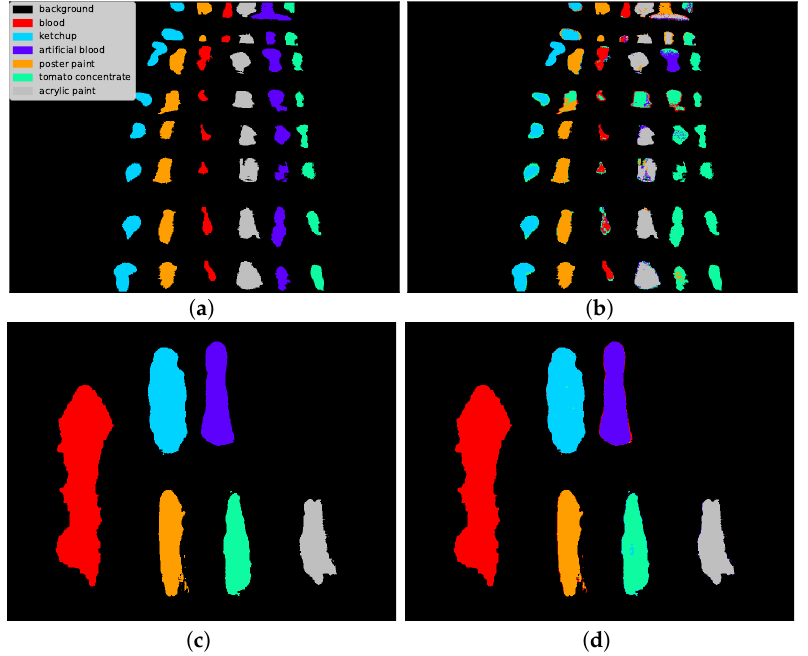
Figure 13. Two selected examples of classification maps for sample runs of the RNN [14] and 3D CNN [49] architectures in the HIC scenario. For the E(1) image, where the training spectra originated from a distinct data cube i.e., F(1) , some classes (e.g., artificial blood and tomato concentrate) were misclassified. However, for the F(2k) image where the training data cube i.e., F(2) originated from the same scene, classification errors are minor, despite the fact that both images were acquired with different hyperspectral cameras. ( a ) Ground truth for E(1) image. ( b ) Prediction of RNN [14] network. ( c ) Ground truth for F(2k) image. ( d ) Prediction of 3D CNN [49]